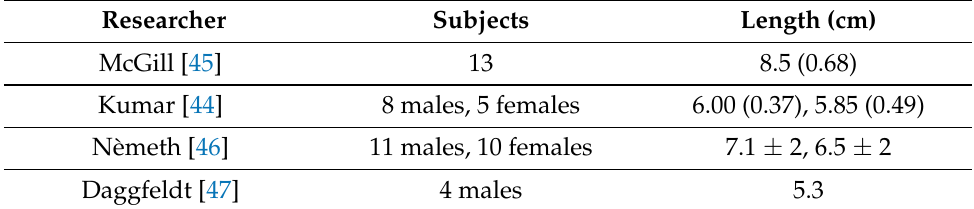
Table 6. Back muscle’s moment arm estimated by previous